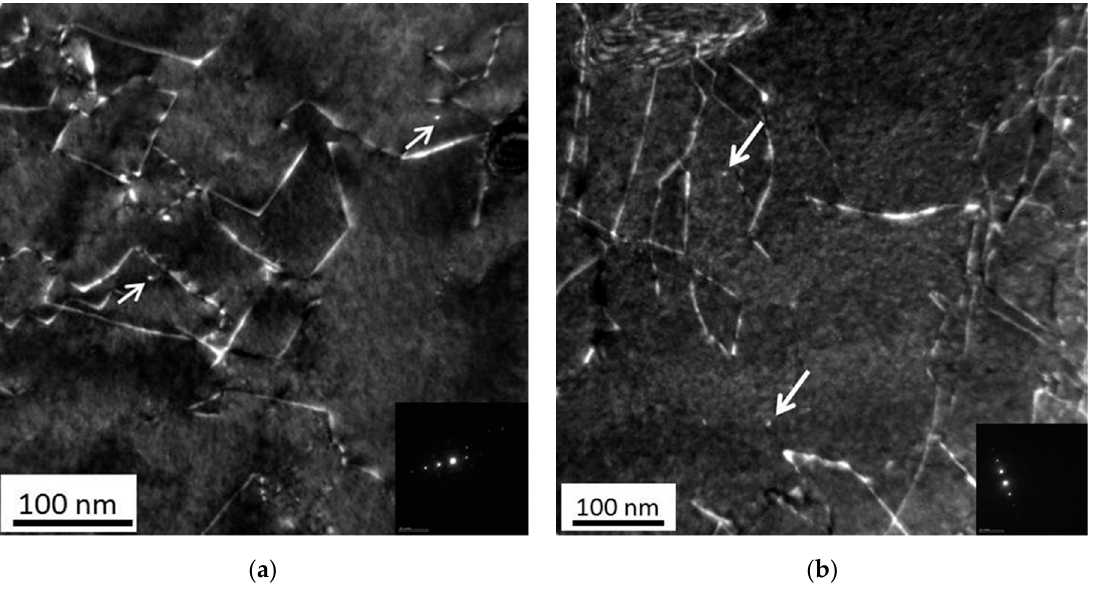
Figure 2. WBDF TEM image for the RPV base material, ( a ) high-flux condition (BH), ( b ) low-flux condition (BL). g = 110. Features identified as dislocation loops are marked with an arrow.